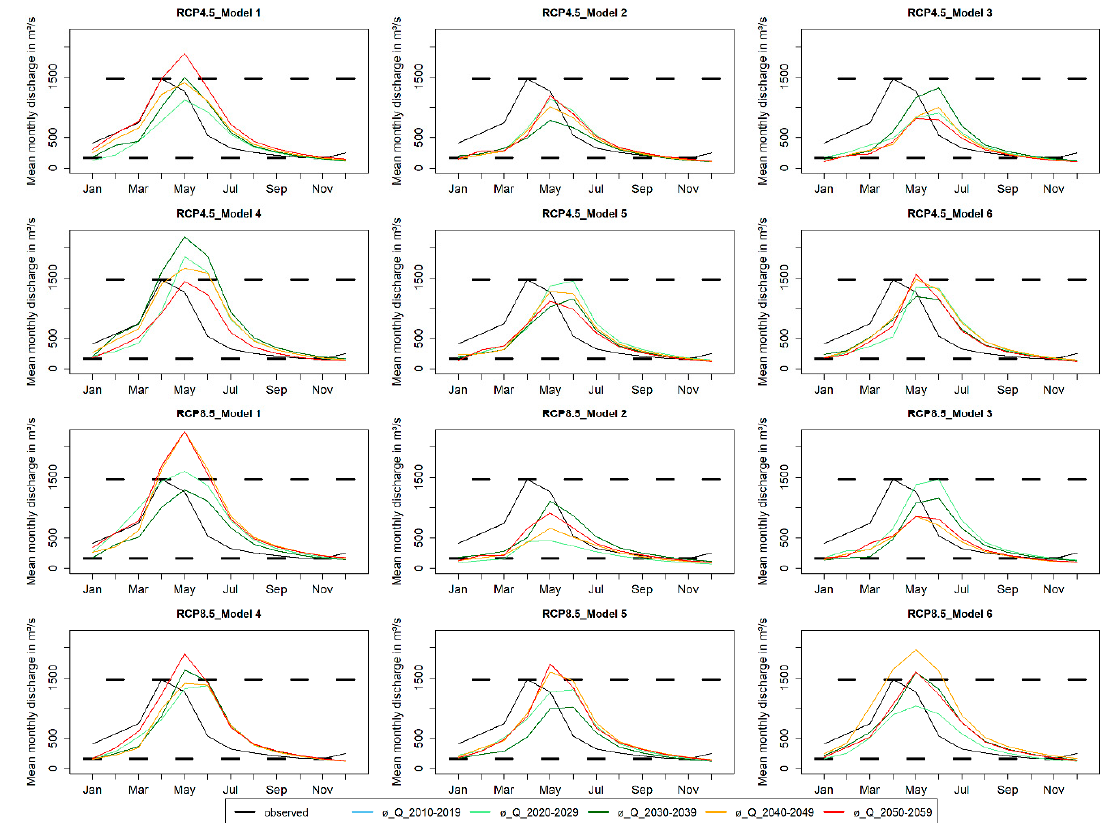
Figure 9. Changes in mean monthly discharge for the RCP4.5 and RCP8.5 scenarios for all utilized regional climate models introduced in Table 2. For each model and RCP scenario the average monthly discharge is visualized on a decadal resolution ranging from 2010 to 2059. Additionally, the mean monthly discharge of the observed discharge from 1958 to 1970 is shown. The dashed lines highlight the minimum and maximum values of the observed discharge for the period 1958–1970.